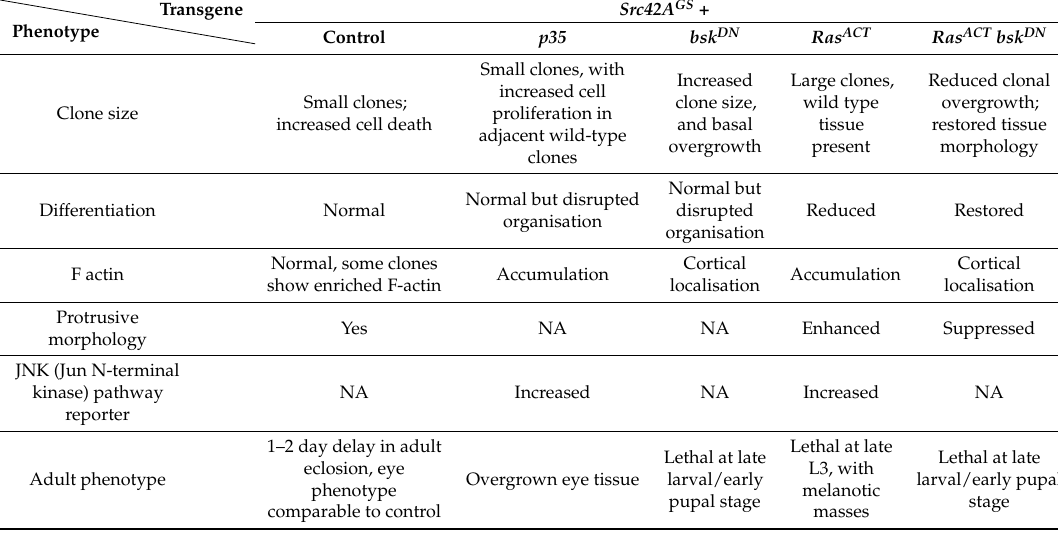
Table 2. Summary of phenotypes of ey-FLP MARCM third instar eye clones expressing Src42A GS with the indicated